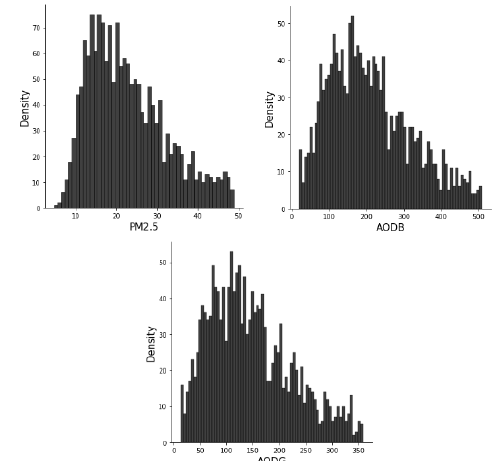
Figure 4. Histogram of the input parameters for PM 2.5